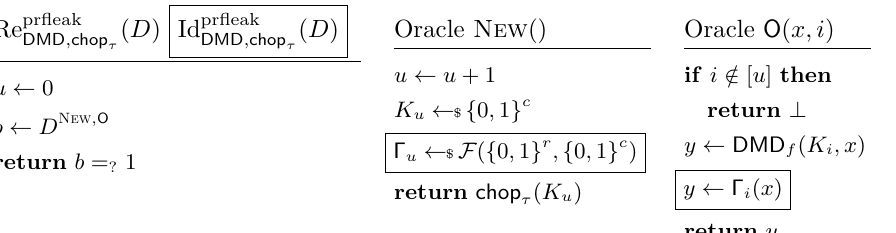
Figure 3.3: Pseudorandom function under leakage